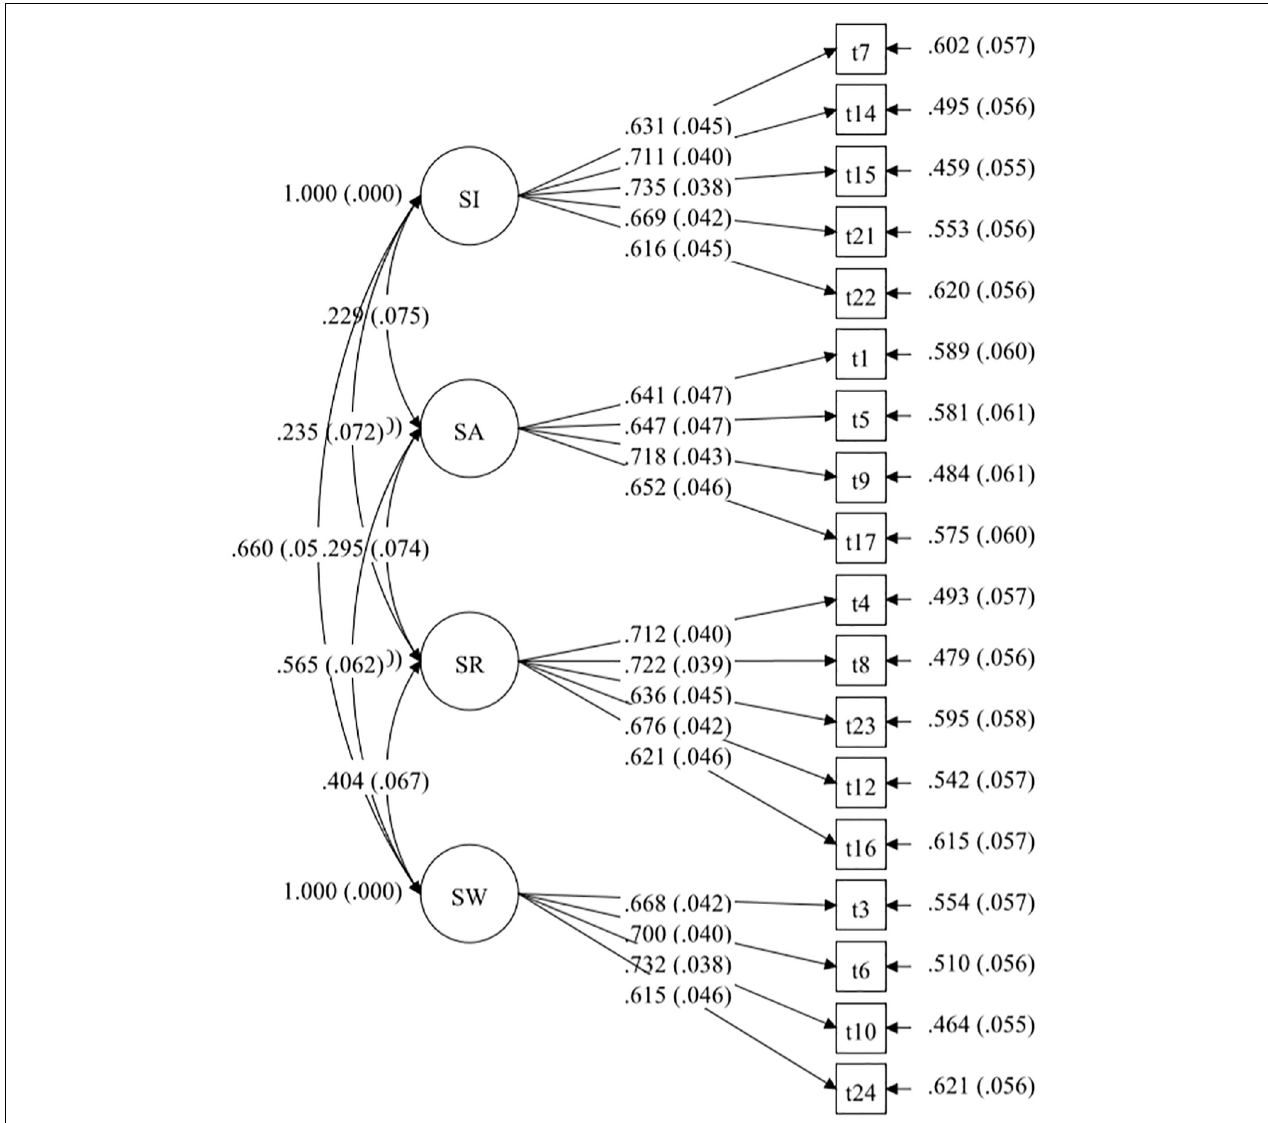
FIGURE 2 | Simulation diagram of the model